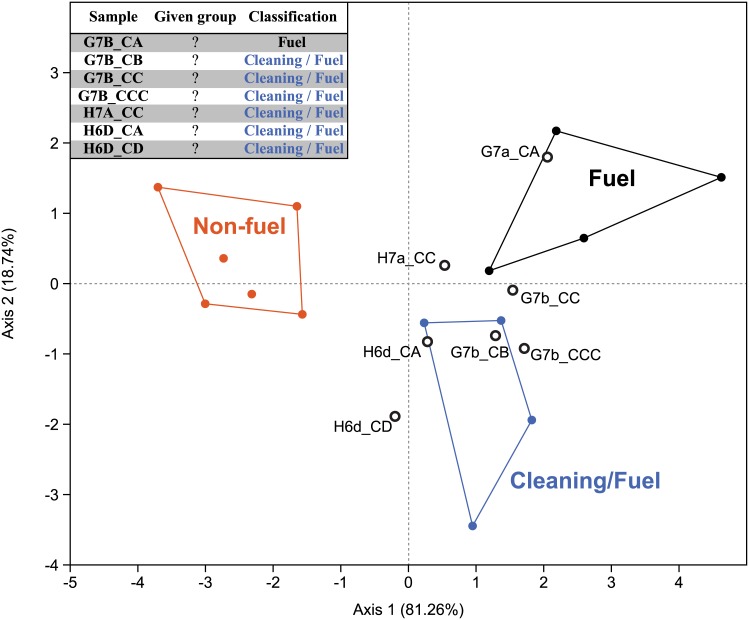
Discriminant analysis of burnt bones.Reference assemblages from Costamagno et al. [32] were used as a training set (plain symbols). The table in the top-left shows the classification of the selected BBC samples by the discriminant analysis (“?” in the given group column refers to the fact that the BBC samples were not used in the training set and only classified a posteriori by the discriminant analysis).